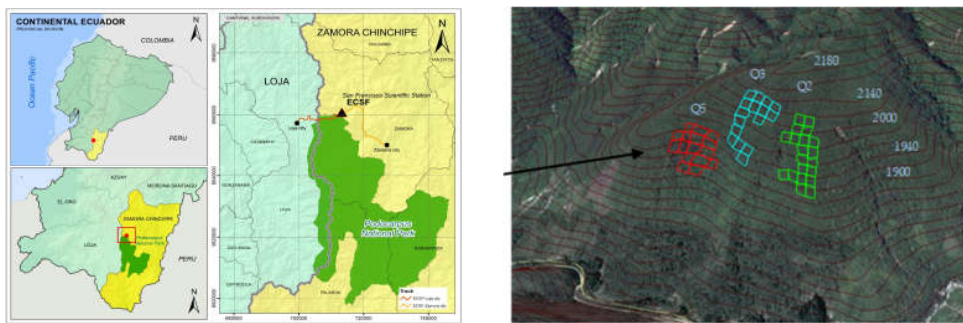
Figure 1. Location of Reserva Biologica San Francisco and Podocarpus National Park. Blocks and plots ubication.